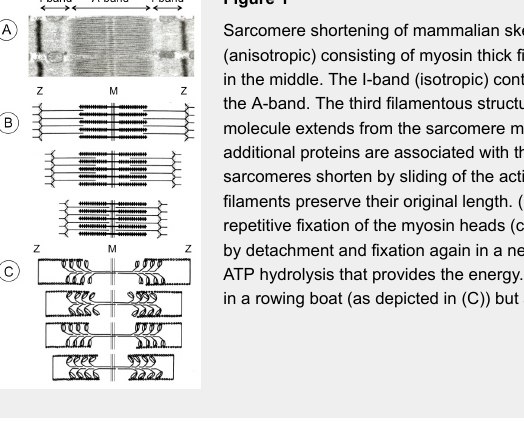
Sarcomere shortening of mammalian skeletal muscle. (A) Electron micrograph of sarcomere displaying A-band (anisotropic) consisting of myosin thick filaments with the interdigitating actin filaments and the M-band proteins in the middle. The I-band (isotropic) contains the thin actin filaments reaching from the Z-discs (black) toward the A-band. The third filamentous structure (not visible in the graph) consists of the giant protein titin. Each titin molecule extends from the sarcomere middle over half the sarcomere length to the Z-disc. Several dozens additional proteins are associated with the three major structural proteins. (B) During muscle contraction the sarcomeres shorten by sliding of the actin filaments toward the sarcomere center while the myosin and actin filaments preserve their original length. (C) The sliding of the two filamentous systems is brought about by repetitive fixation of the myosin heads (crossbridges) at actin, bending toward the sarcomere middle, followed by detachment and fixation again in a new position. This cyclic movement of the myosin heads is coupled